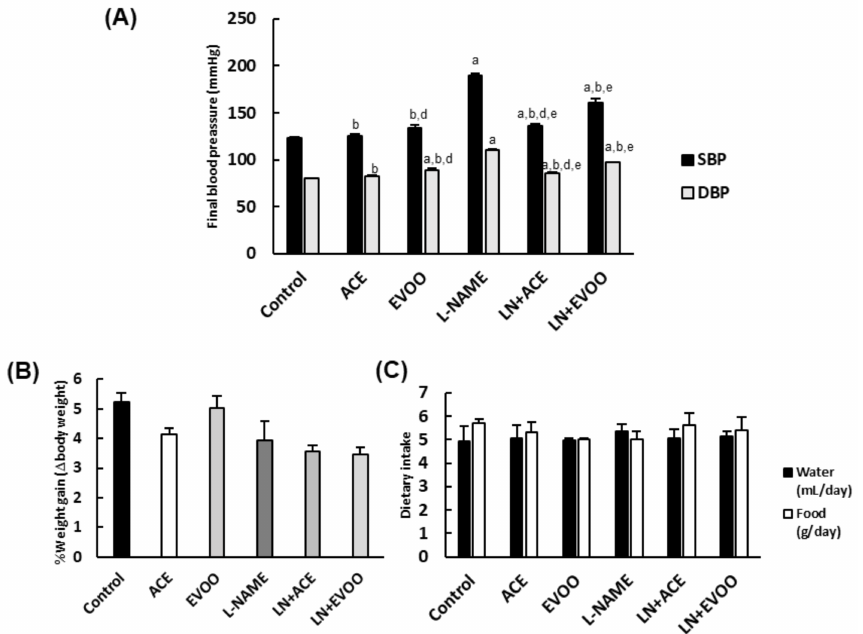
Figure 1. General parameters. ( A ) Final blood pressure, ( B ) weight gain and ( C ) liquid and solid diet intake in the six experimental animal groups. Values are expressed as mean ± SEM of seven animals per group: a p < 0.05 vs. Control; b p < 0.05 vs. L-NAME; d p < 0.05 vs. LN + EVOO; e p < 0.05 vs.